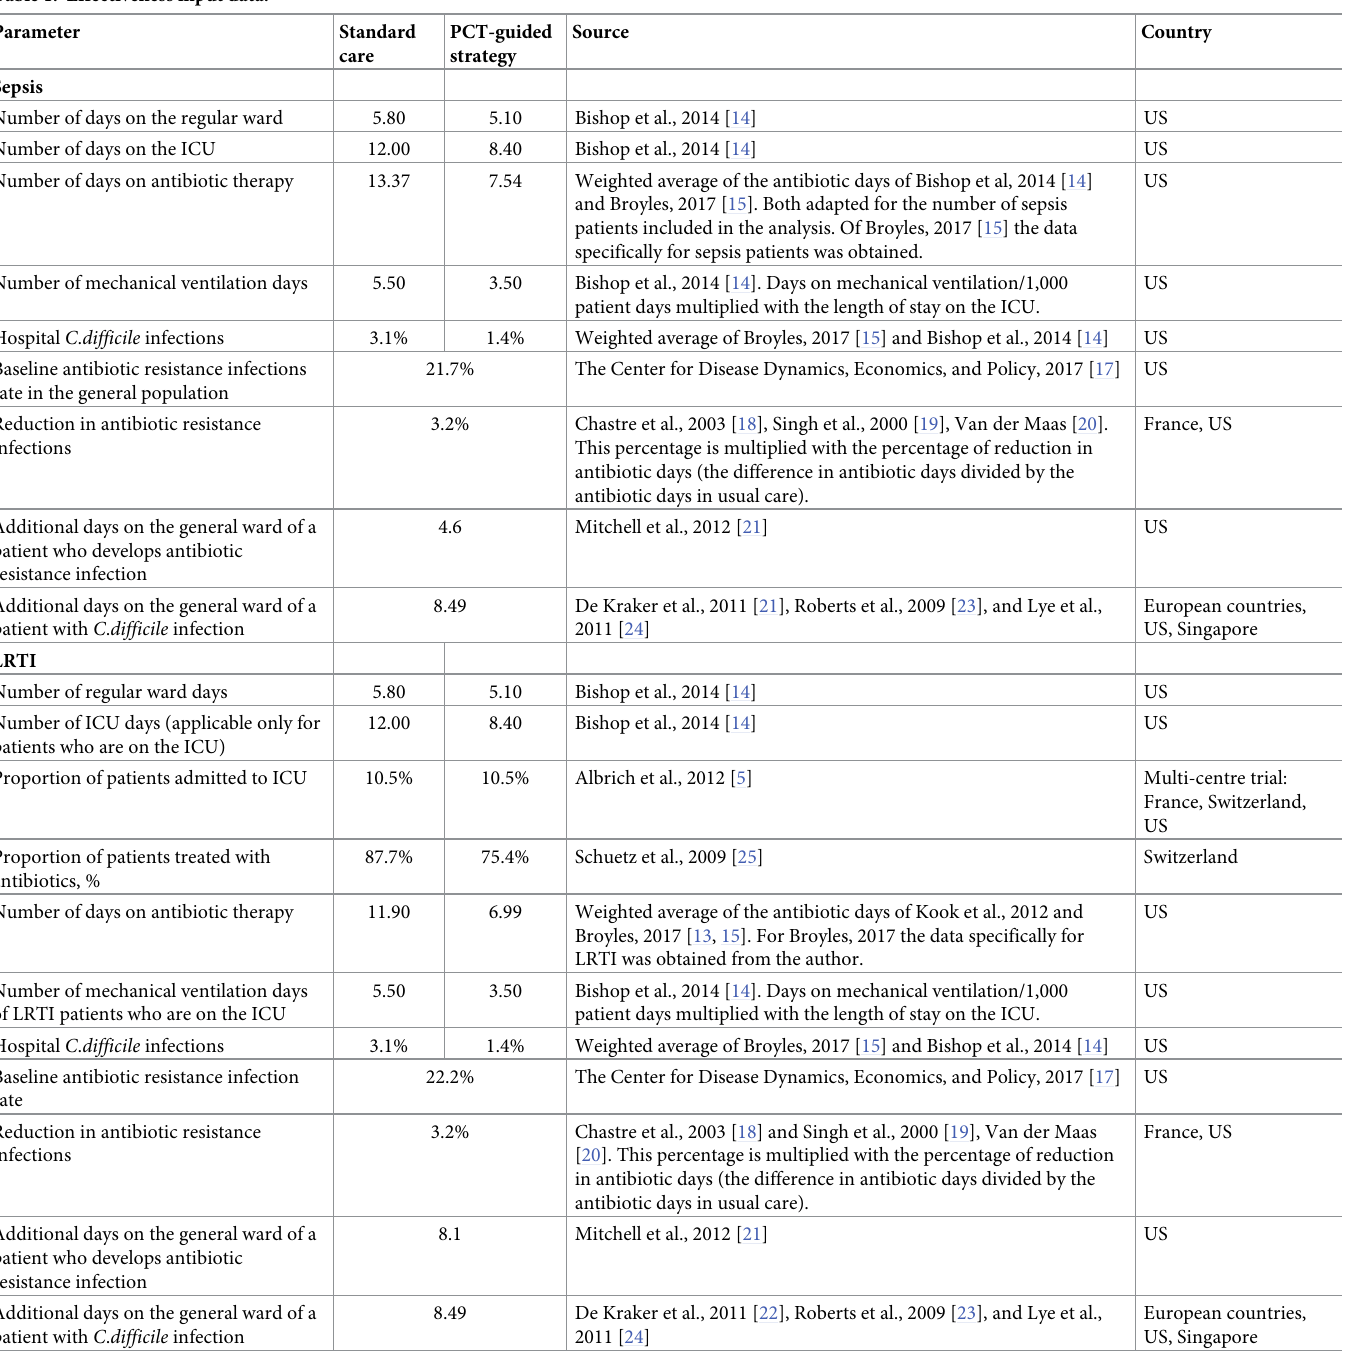
Table 1. Effectiveness input